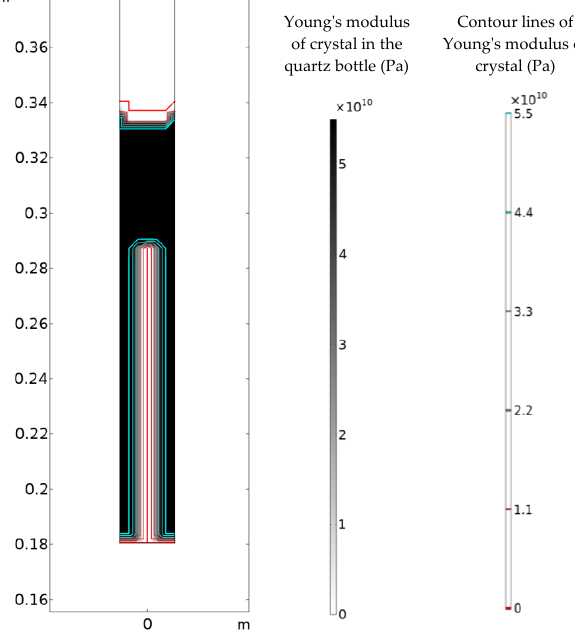
Figure 6. The internal contour plot of the quartz bottle.